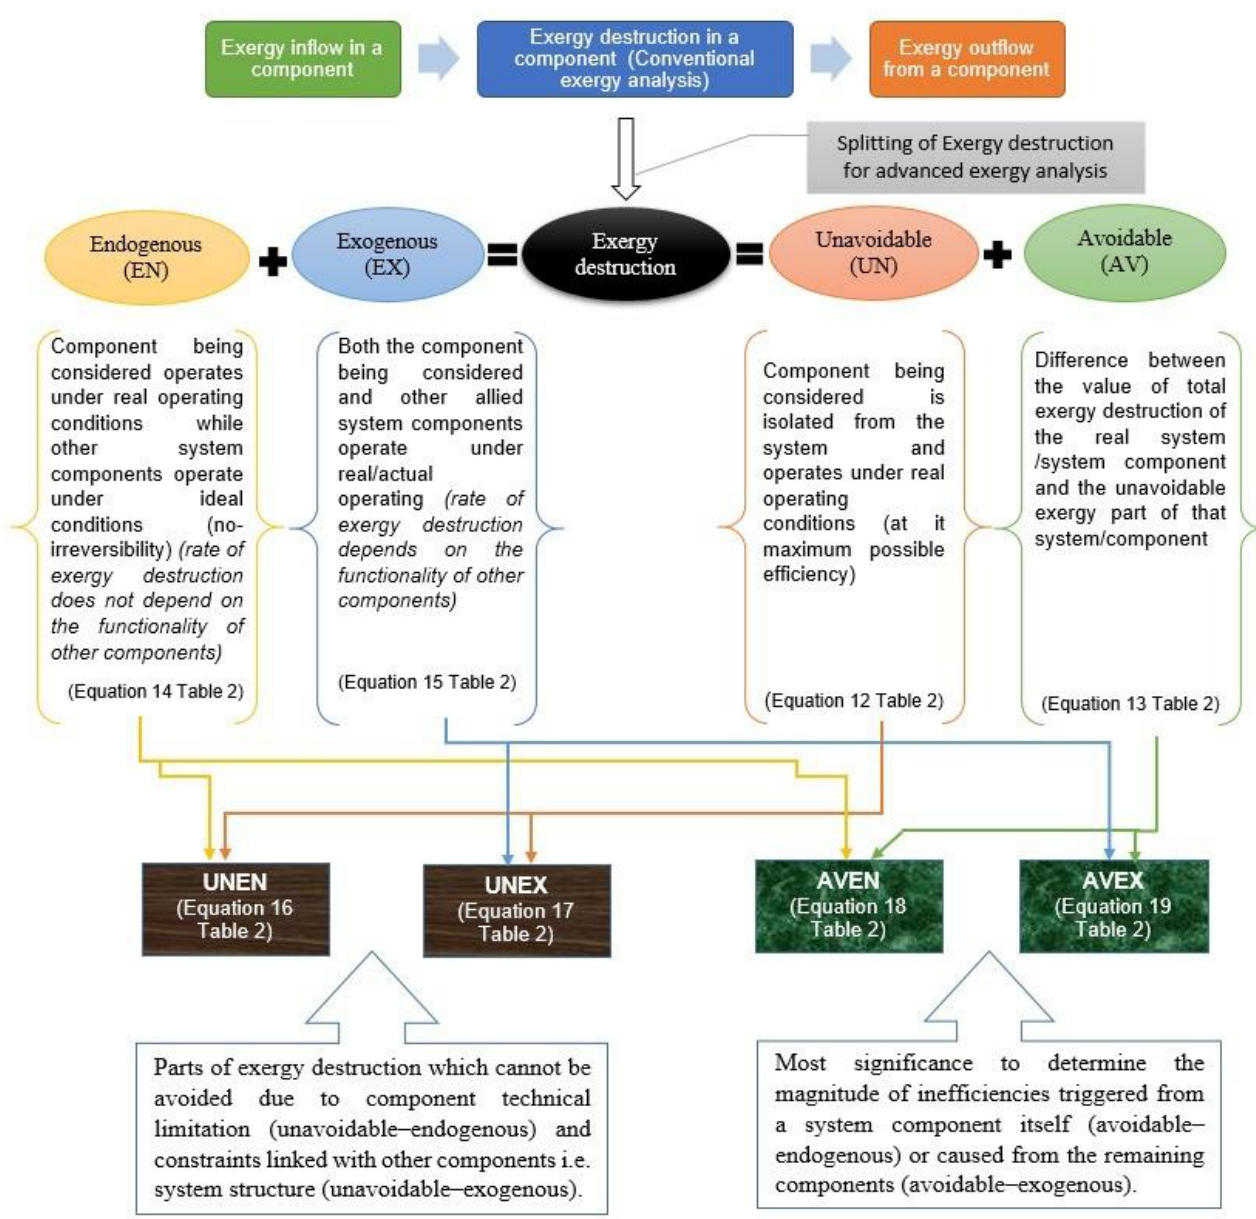
Figure 4. Flowchart of splitting the exergy destruction of conventional exergy analysis into different parts for advanced exergy analysis of solar hybrid food dehydrator. Table 2. Equations used for the calculations of various parameters required to perform advanced exergy analysis.